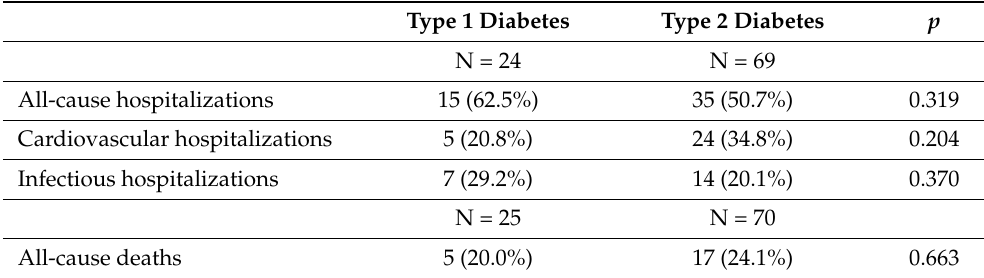
Table 5. The frequency of cardiovascular, infectious, and all-cause hospitalizations, with all-cause patient deaths divided according to the type of diabetes.